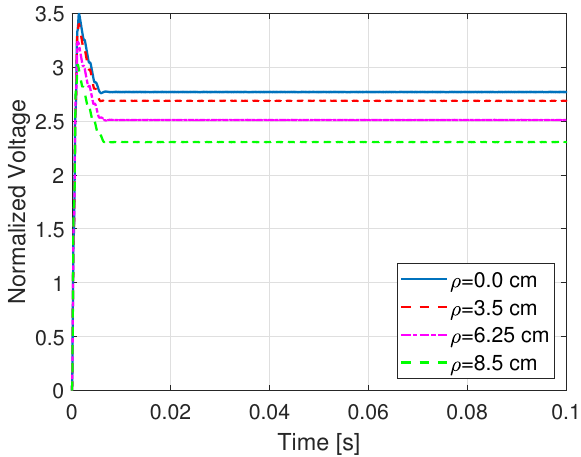
Figure 7. Load normalized voltages with h = 15 cm.